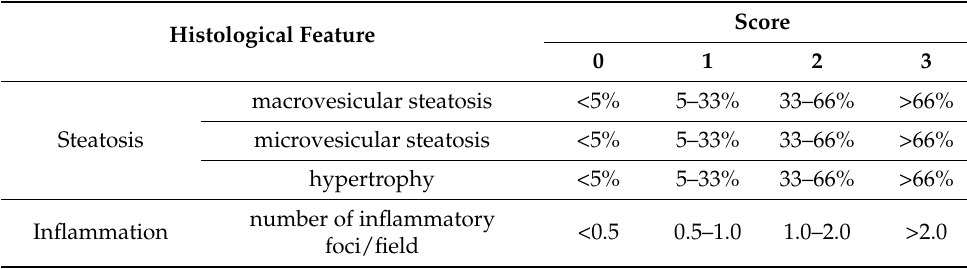
Table 6. NAFLD Scoring System for Rodent